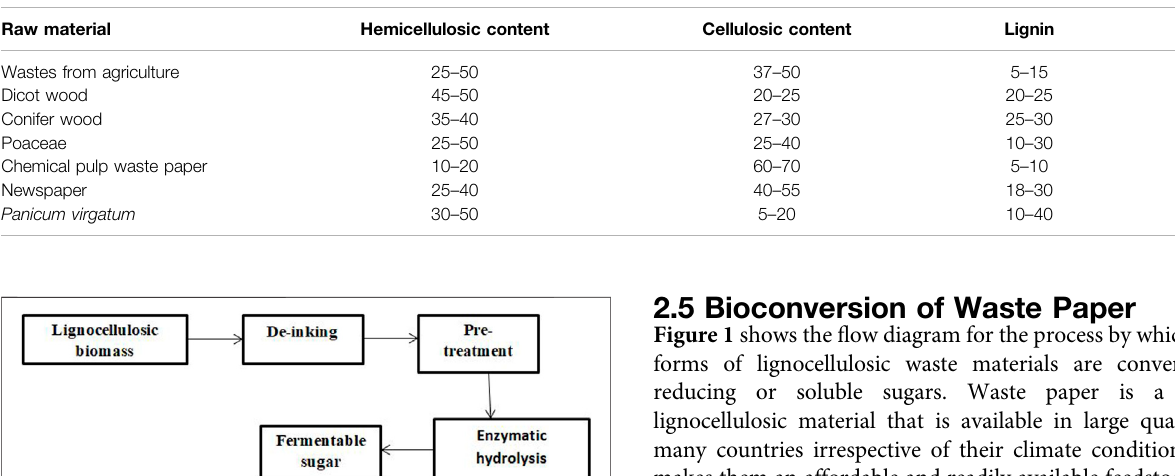
TABLE 1 | Examples of lignocellulosic raw materials and their chemical compositions (% dry weight) (Fatma et al., 2018).